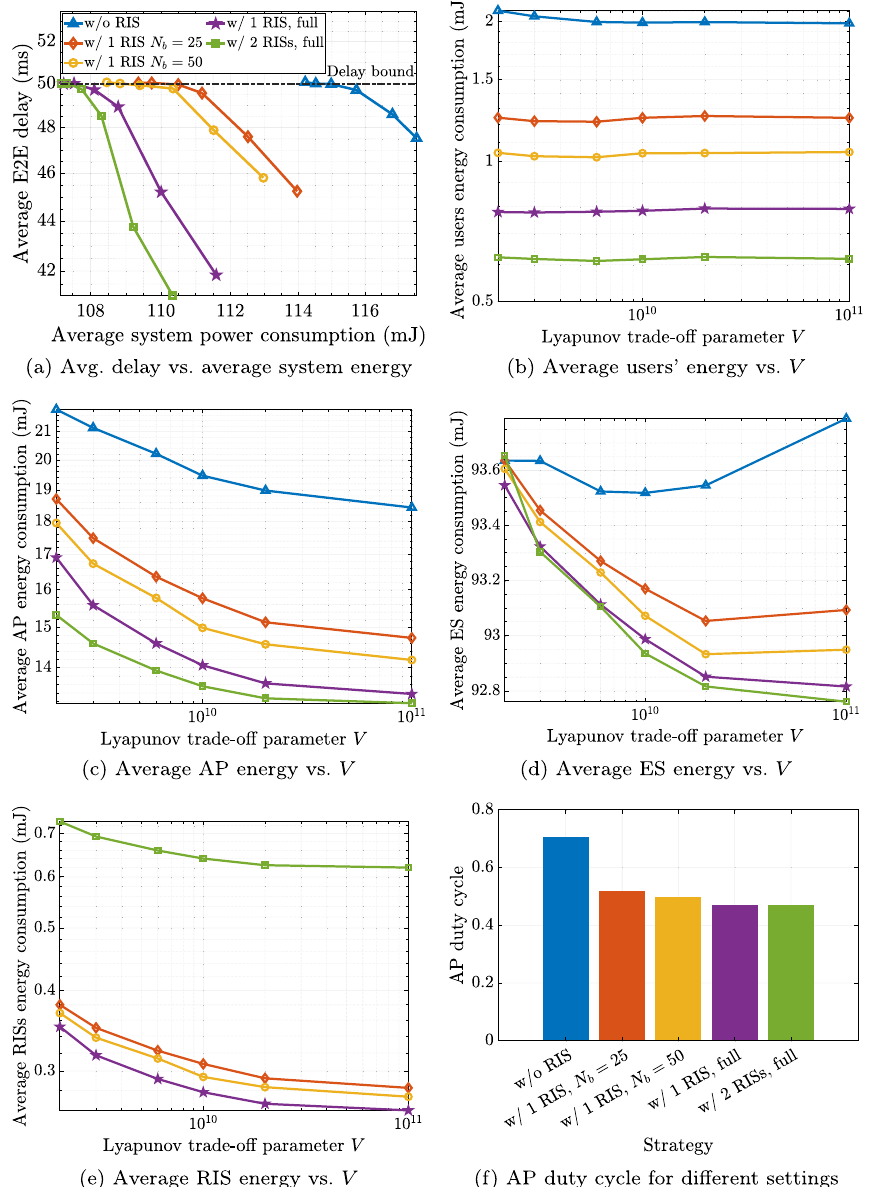
Fig. 4 Energy-delay trade-off in a multi-user